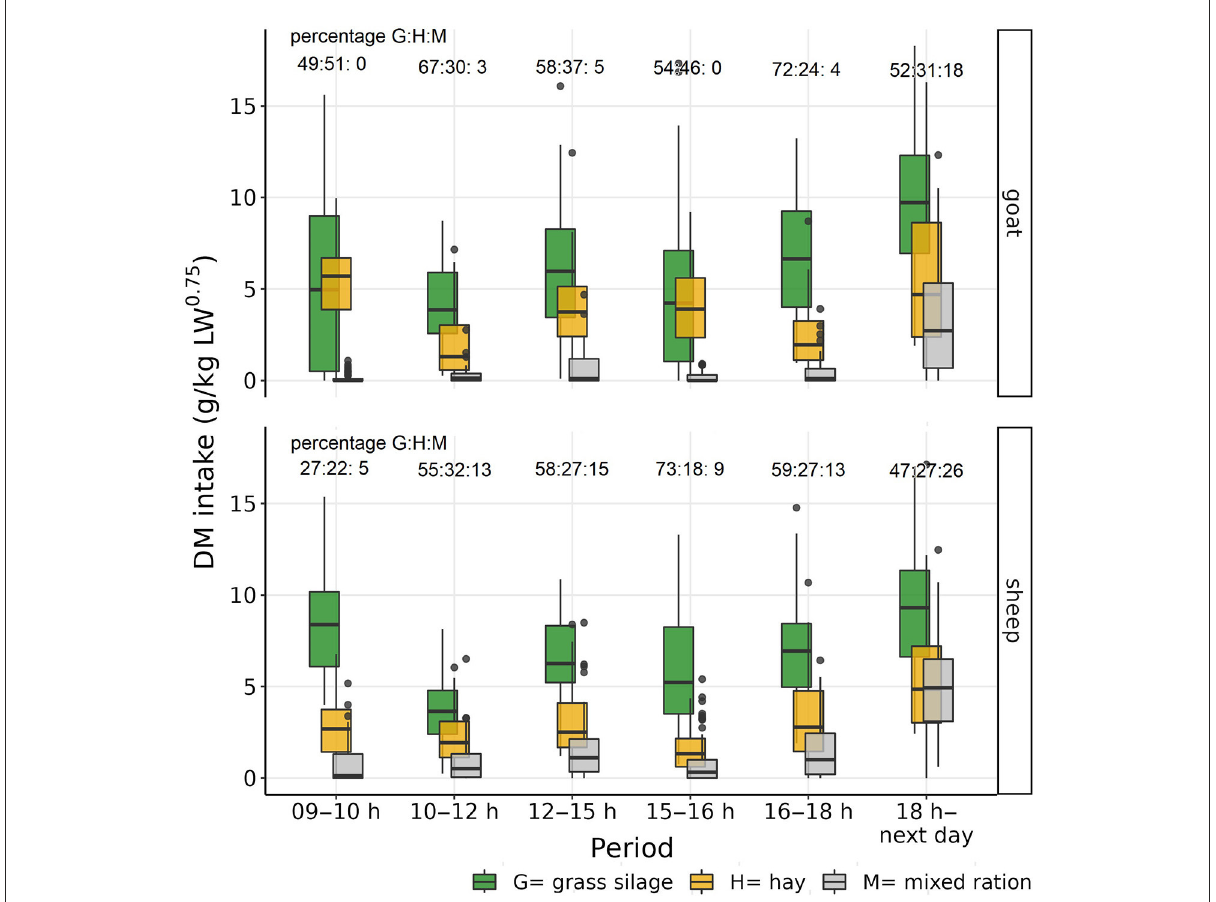
FIGURE3 Boxplot of observed individual goats’ and sheep’s dry matter (DM) intake of the three experimental feeds, grass silage (G), hay (H), and the mixed ration (M), during the different observation periods.